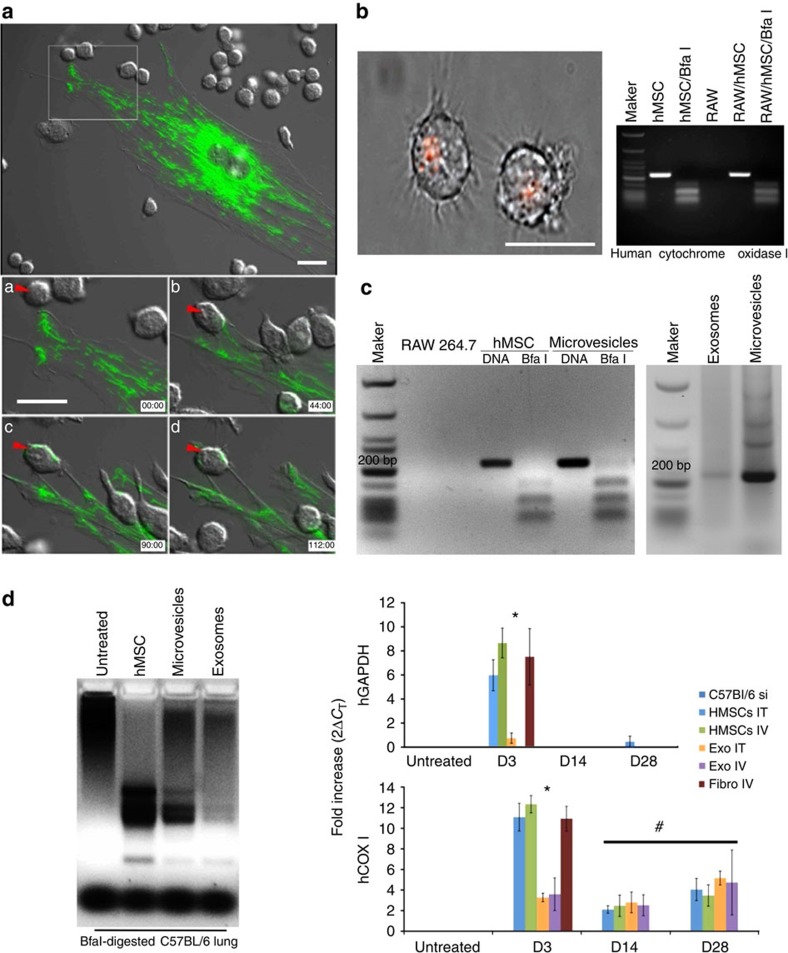
MSC transfer mitochondria to macrophages and lung tissues.(a) Top panel is DIC fluorescent overlay at time 0 of primary human MSCs infected with Organelle Lights to label mitochondria (green) and co-cultured with mouse (RAW 264.7) macrophages. Lower panels, time sequence at 45 min intervals showing transfer of green-labelled mitochondria from the a MSC to a macrophage (red arrow, see Supplementary Movie 4 for transfer of mitochondria in filamentous form, and Supplementary Movie 5 in which GFP signal is compensated to allow the tracking of the transferred mitochondria into macrophages). (b) Left panel, photomicrograph of FACS-sorted mouse macrophages that were co-cultured with mitochondria-labelled (RFP) human MSCs clearly show retention of RFP label. Right panel, electrophoretic pattern of human COX I PCR product treated with or without Bfa1 after amplification from the indicated cell sources. (c) MSC-derived exosomes and MVs express the Bfa1-sensitive 228-bp COX I mtDNA PCR product detected in human MSCs (b). (d) Left panel, electrophoretic pattern of Bfa1-digested human COX1 PCR product amplified from mouse lung DNA isolated 14 days after the intravenous administration of human MSCs, human MSC-derived MVs or exosomes. Right panel, human GAPDH and human COX1 relative expression levels quantified by RT–PCR in mouse lung (3–28 days) after a single (intratracheal (IT) or intravenous (IV)) injection of human MSCs, human MSC-derived exosomes or human fibroblasts. *P<0.001, #P<0.001 by ANOVA compared with untreated mouse lung. Plotted values (mean±s.e.m.) are from experiments repeated four times. Scale bars, 20 μ.